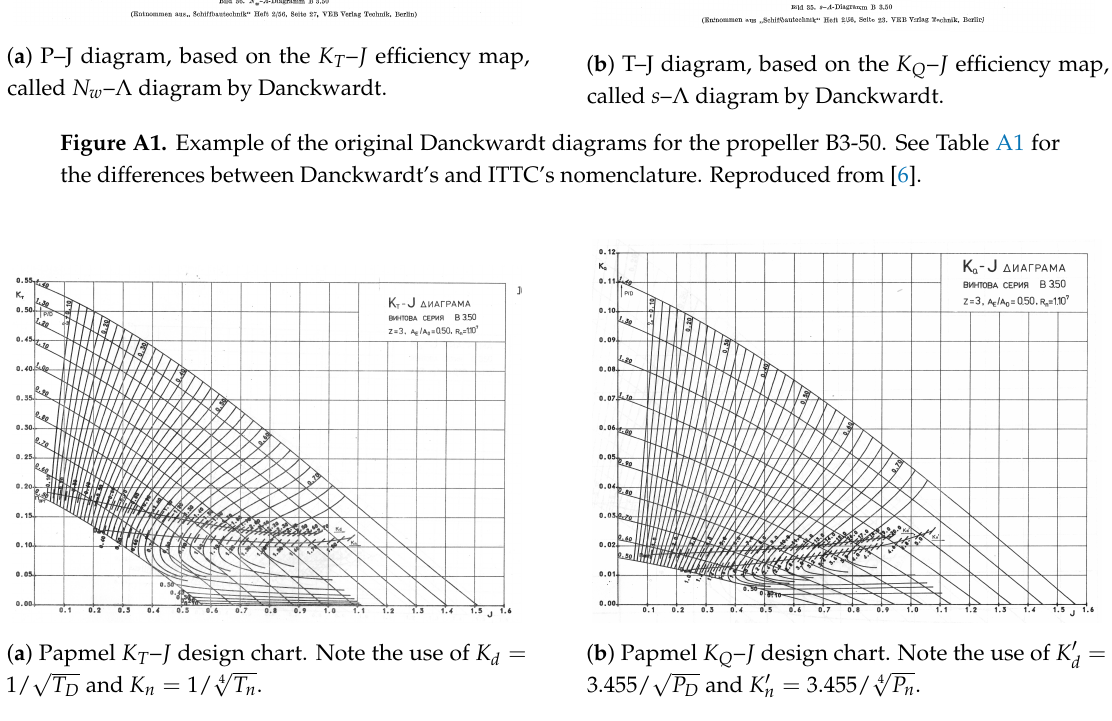
Figure A2. Example of the original Papmel design charts for the propeller B3-50, as recreated by Yosifov et al. Reproduced from [14], with permission from Bulgarian Ship Hydrodynamics Centre, 1983. Table A1. Differences between the nomenclature used by Danckwardt and